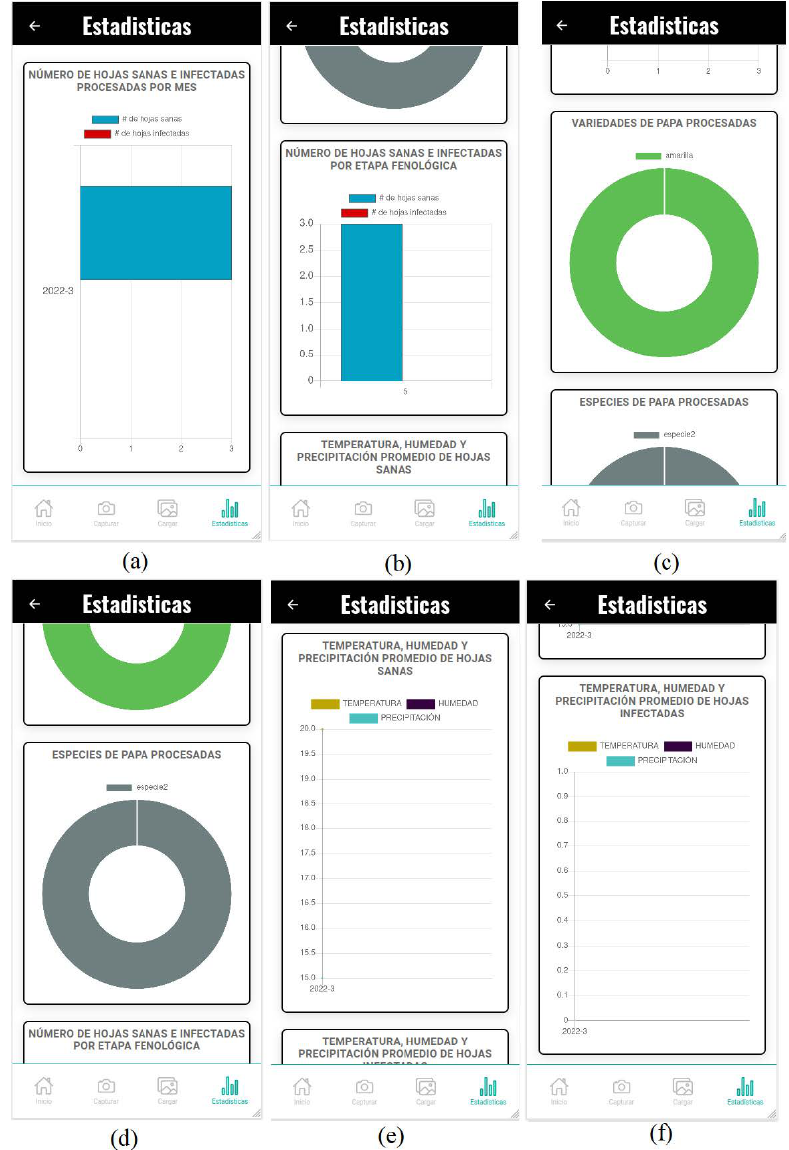
Figure 10. Prototype designs of obtained data visualization for administrators.